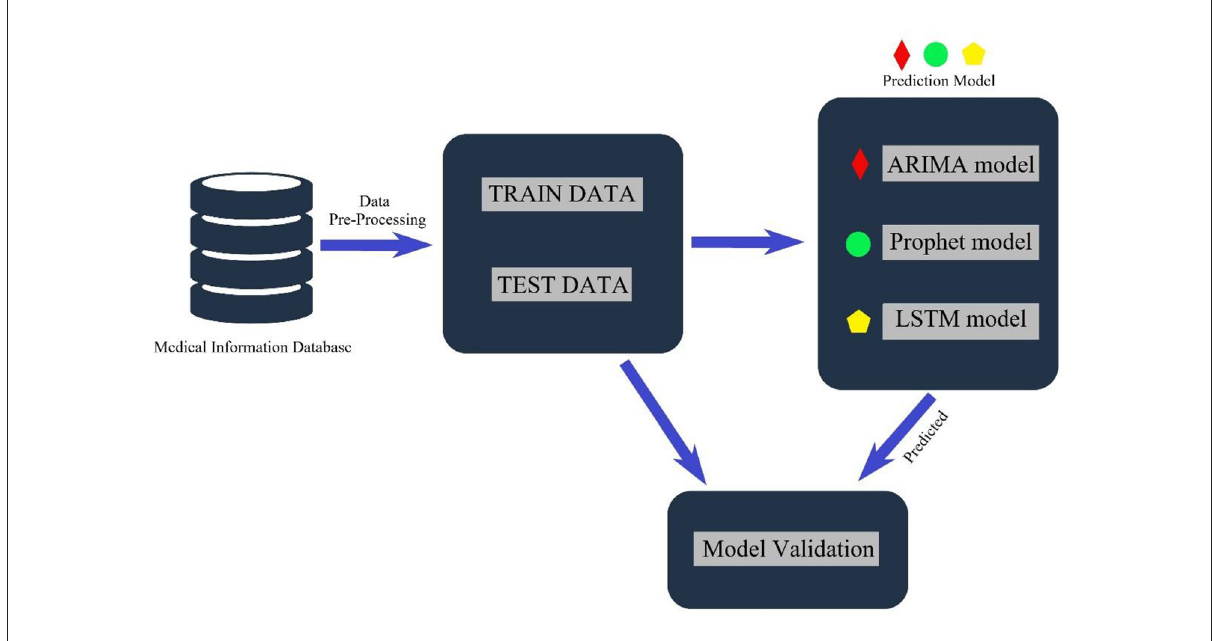
FIGURE1 Architecture of the RTIs predictive